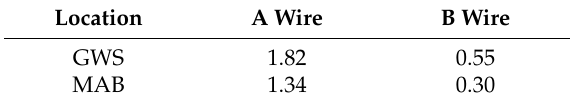
Table 5. Plasticity indexes for bead-on-plate welds made using A and B wires after storage.